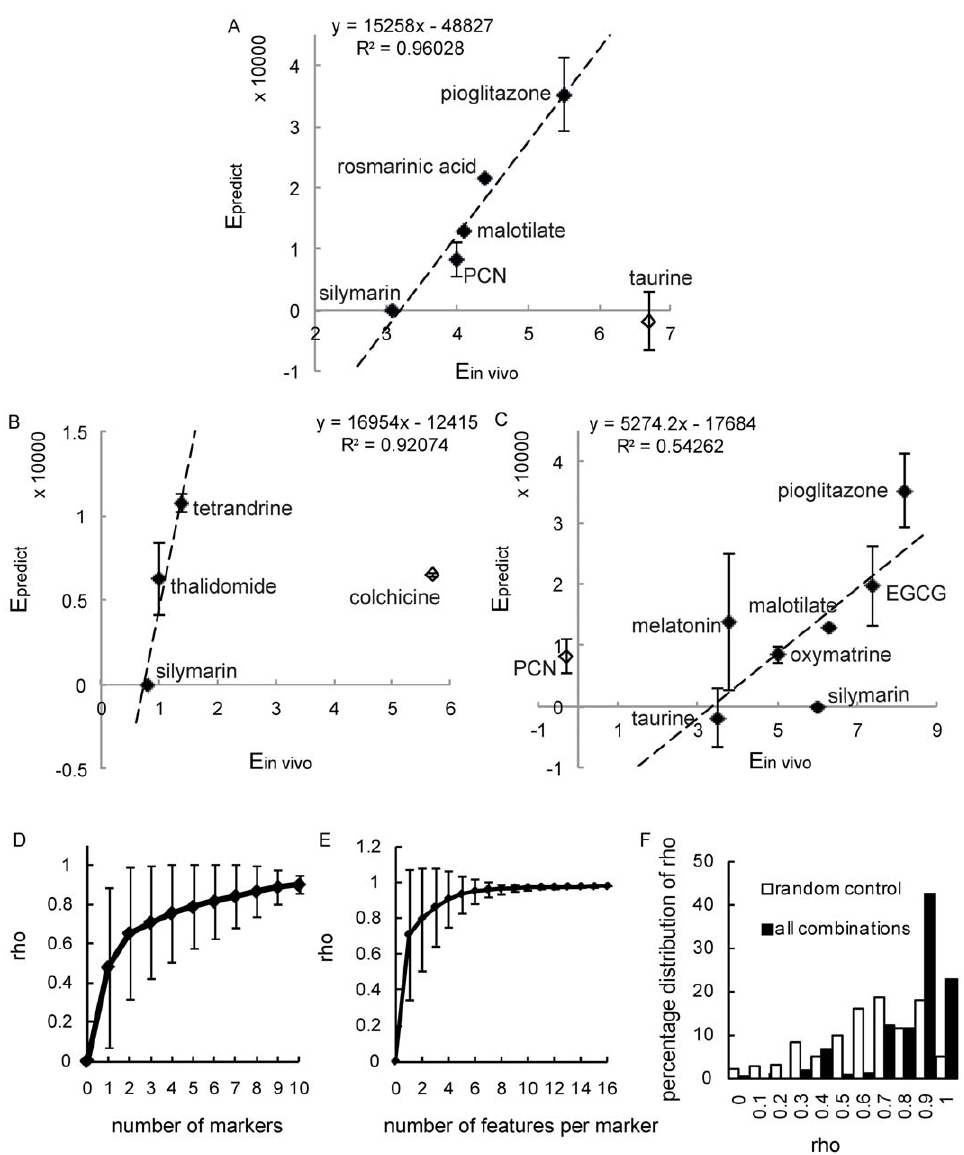
Figure 3. Correlation between E predict and E invivo . (A) Optimization of E predict . E predict is computed as a weighted combination of the features with weights optimized using Spearman’s rank correlation test to best correlate with E in vivo from the CCl 4 treatment model. (B, C) Blind validations of in vitro - in vivo correlation between E predict and E in vivo from two independent datasets containing DMN treatment and CCl 4 preventive models respectively. The linear relationship is highlighted using linear regression lines in all (A, B and C). The equations of the linear regression lines and the R 2 values are computed without considering the outliers in the graphs ( i.e. , taurine in A, colchicine in B and PCN in C). (D) The relationship between the average rho value and the number of markers. (E) The relationship between average rho and the number of features per marker. Error bars represent standard deviation. (F) The percentage distribution of rho is plotted for all possible combinations of the 3 weights and 10 markers. The random control was done by randomizing the relative ranks of the in vivo drug efficacies for the Spearman’s rank correlation